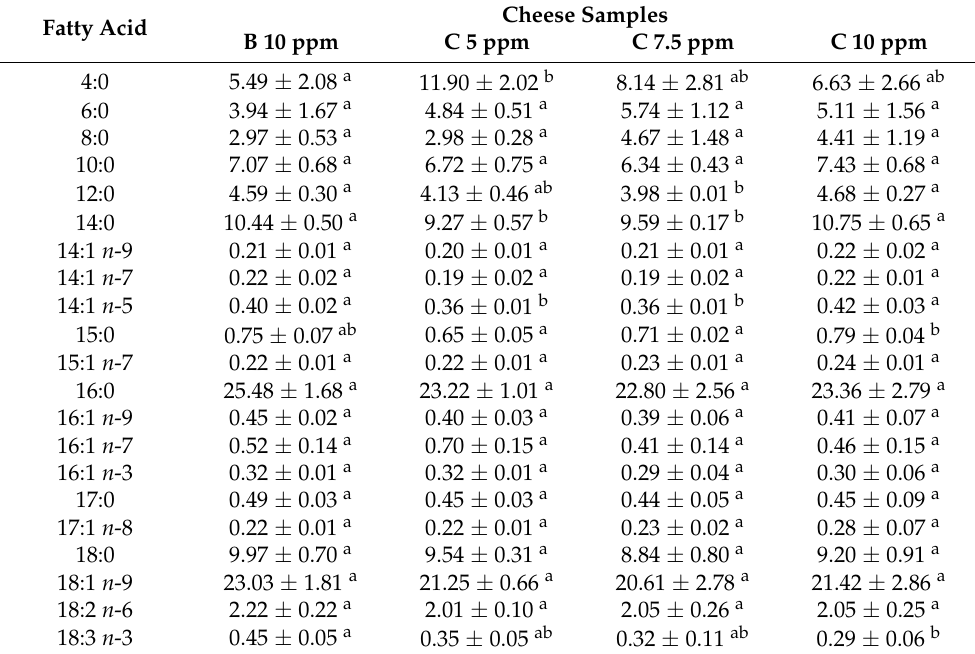
Table 4. Fatty acid composition of the manchego-style cheeses on ripening day